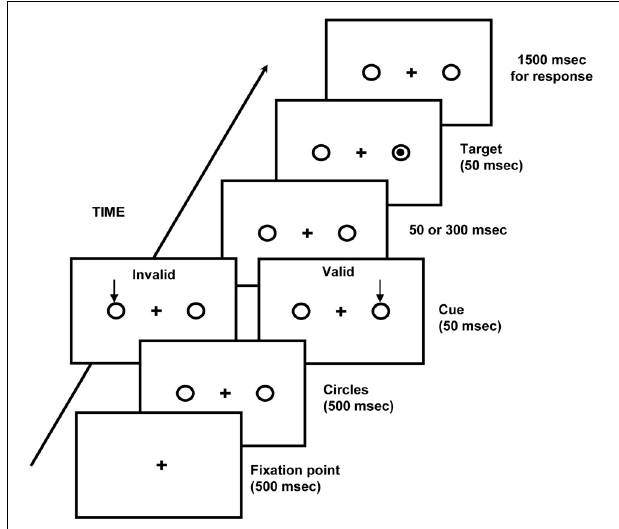
FIGURE 2 | Schematic representation of the display used in the visual temporal attention task (A); Stimuli used in the visual temporal attention task